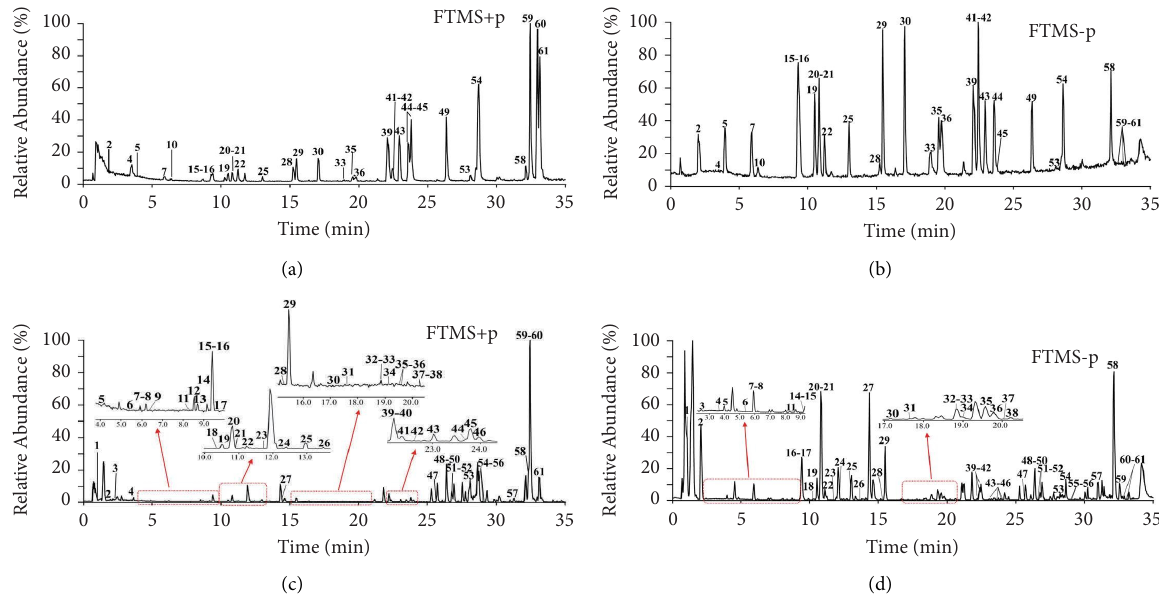
Figure 1: Total ion chromatograms of reference compounds in (a) positive ion mode and (b) negative ion mode and QZC in (c) positive ion mode and (d) negative ion